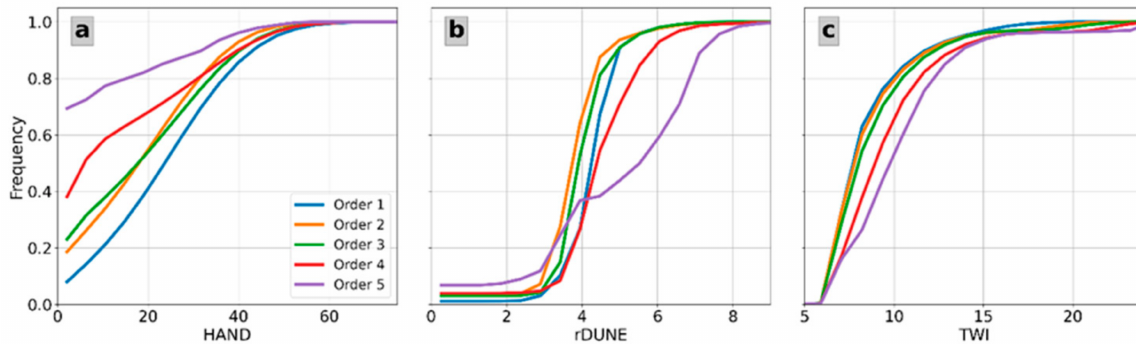
Figure 8. Cumulative distribution of the HAND ( a ), rDUNE ( b ), and TWI ( c ) discriminated by the Horton order of the Nishnabotna